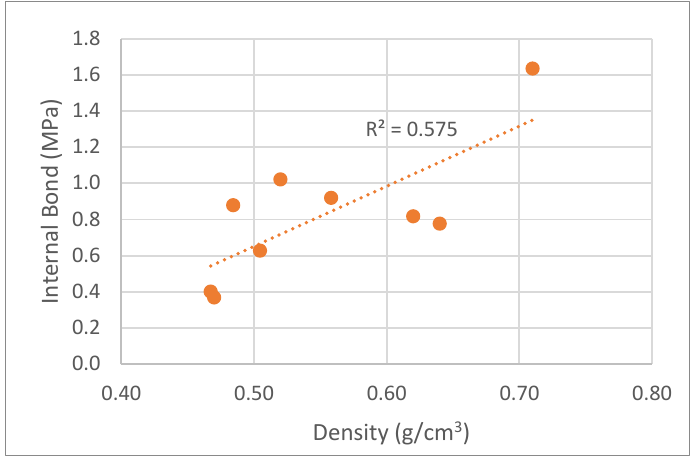
Figure 11. Correlation between internal bond variation with particleboard density.